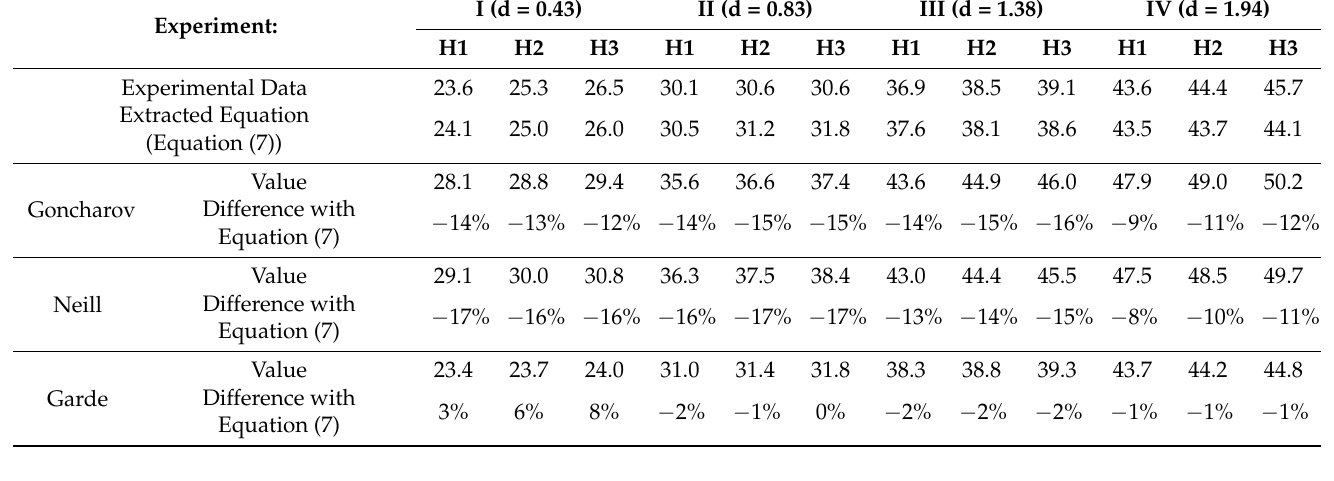
and U cr √ in this study, compared to results of other studies. and 𝑈 𝑐𝑟 in this study, compared to results of other studies. d ∆ gd 𝑑 √∆𝑔𝑑